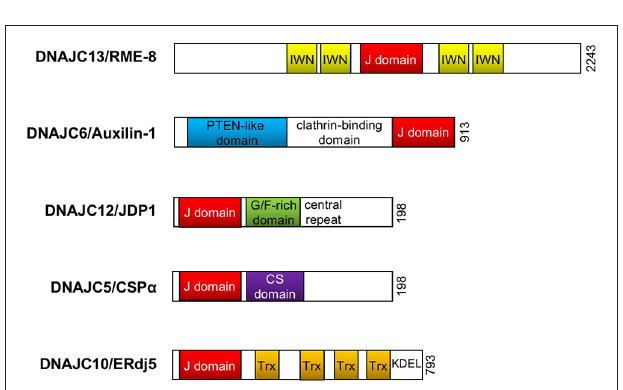
FIGURE 2 | DnaJ/Hsp40 proteins implicated in Parkinson’s disease. Schematic illustration of the functional domain organization of DnaJ proteins (DNAJC8/RME-8, DNAJC6/Auxilin-1, DNAJC12/JDP1, DNAJC5/CSP α , and DNAJC10/ERdj5) reviewed in this article. The illustration does not represent the actual molecular size. PTEN, phosphoinositide phosphatase; G/F, glycine/phenylalanine; CS, cysteine-string; Trx, thioredoxin; KDEL,